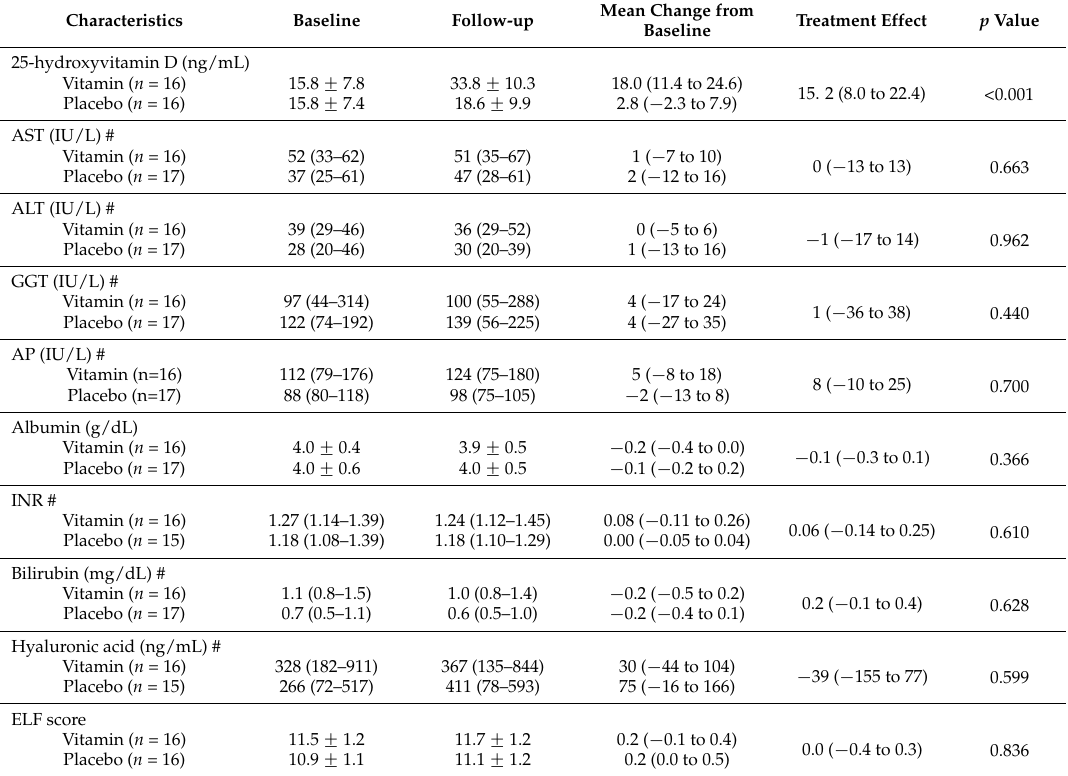
Table 2. Outcome variables at baseline and follow-up and changes from baseline in study participants with available values at both study visits.